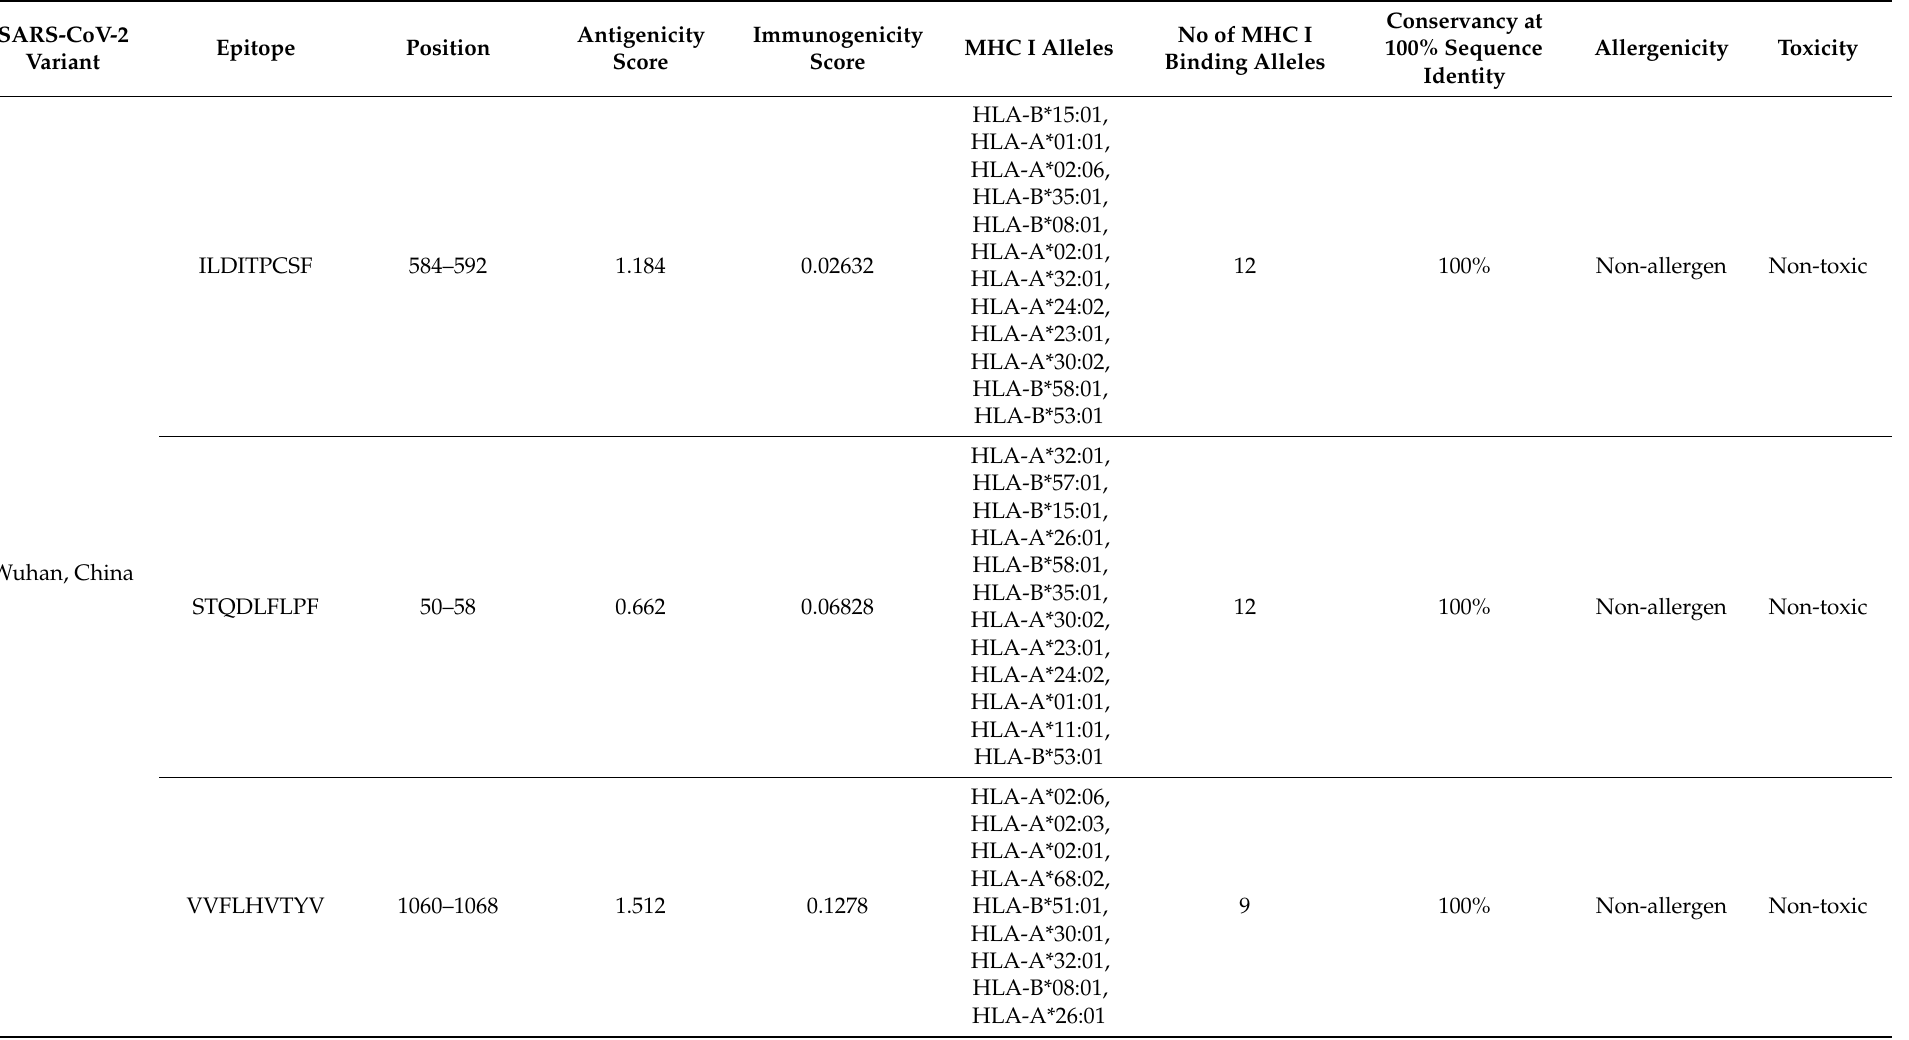
Table 2. Best cytotoxic T lymphocyte epitope 9mers and their immunogenic characteristics predicted for the three different SARS-CoV-2 variants from the IEDB tool.